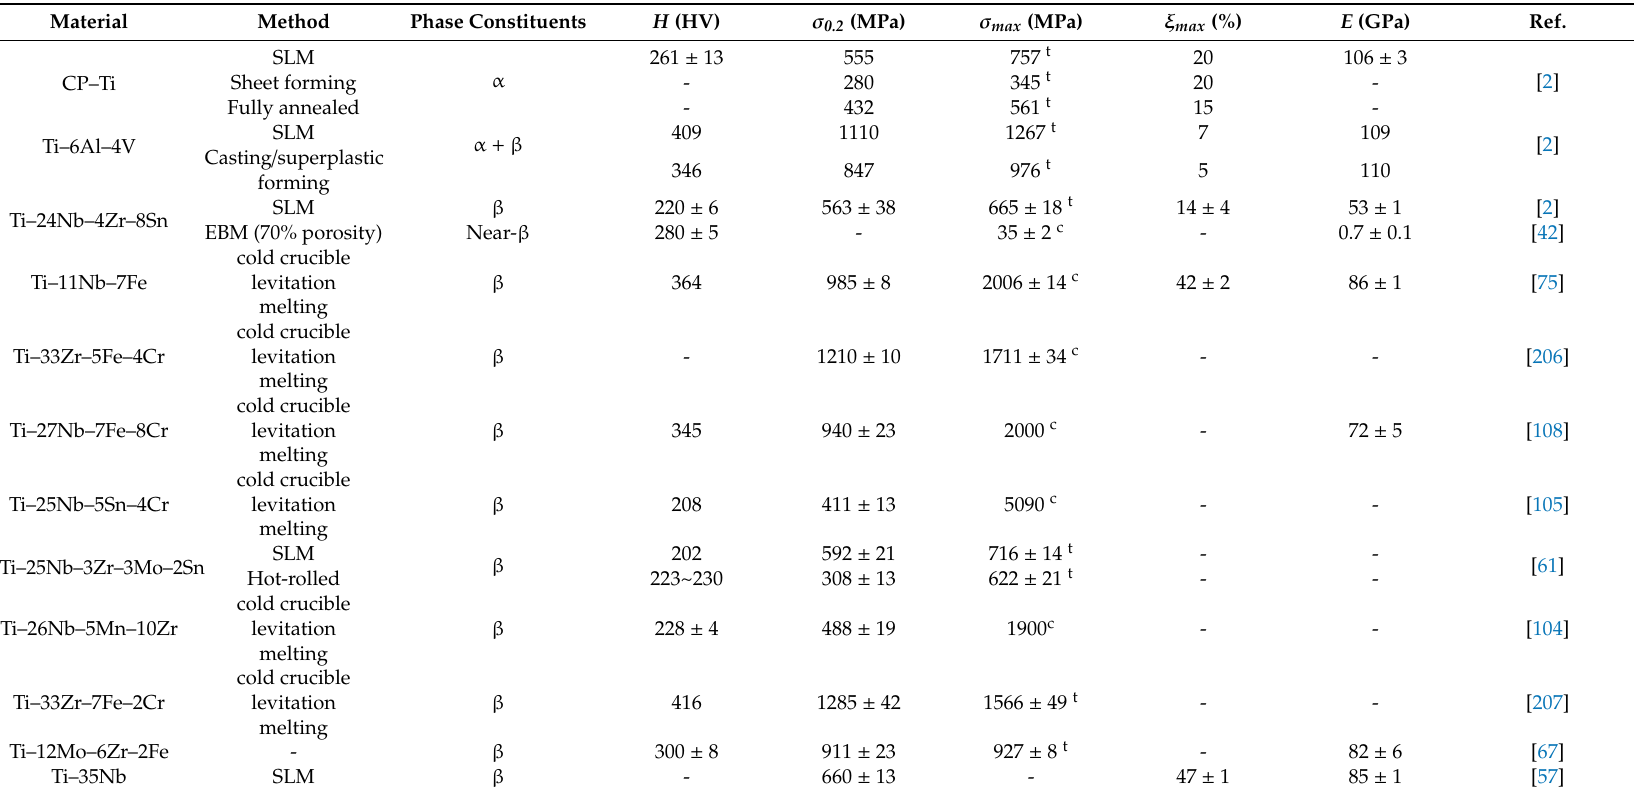
Table 3. Mechanical properties including hardness (H), yield strength ( σ 0.2 ), ultimate strength ( σ max ), fracture strain ( ξ max ), and elastic modulus (E) for di ff erent types of Ti alloys by a variety of fabrication